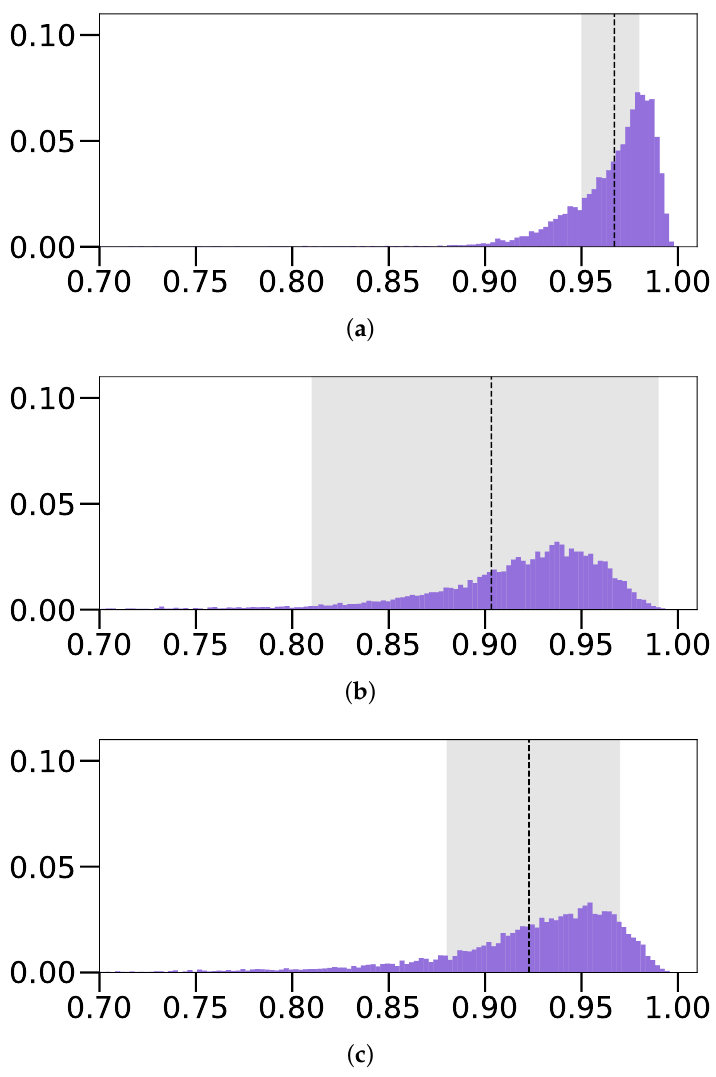
Figure 12. Distributions of IoU values obtained when training the model on variations of the Blue on Gray (BoG) images. ( a ) BoG ( Fixed z ); ( b ) BoG ( Free z ) with shadows; ( c ) BoG ( Free z ) with shadows and